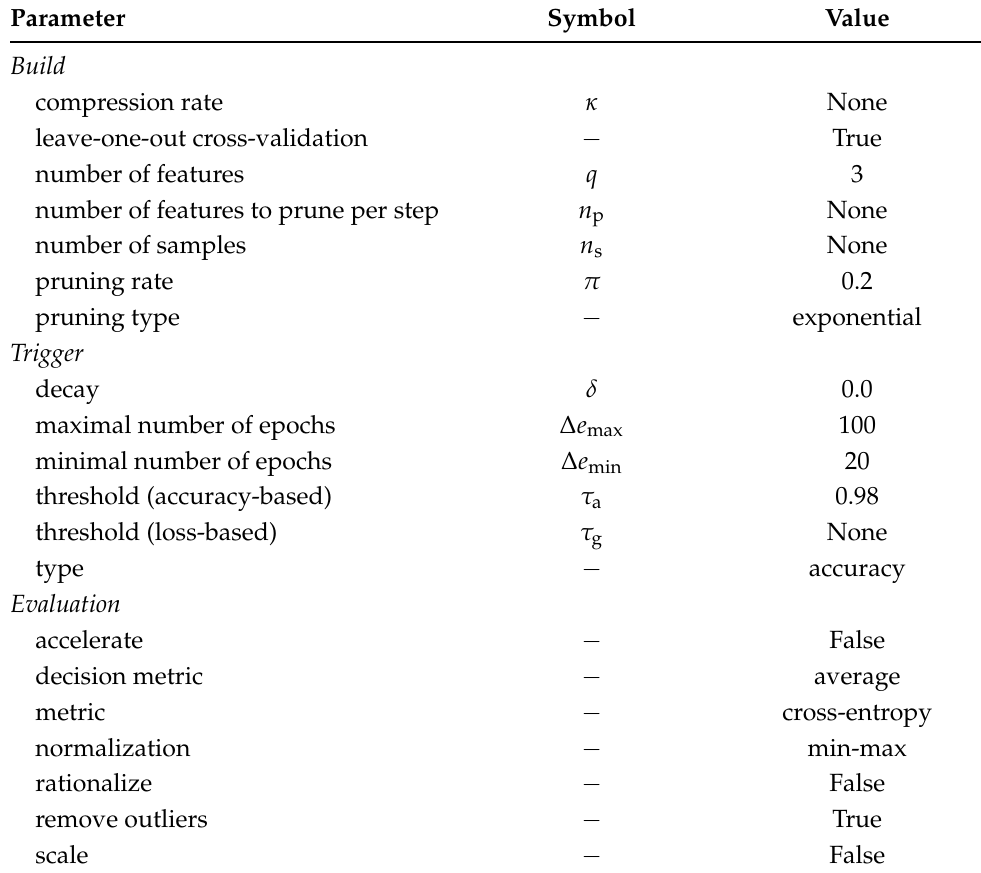
Table A2. Specified values for the FeaSel-Net building parameters. Parameter